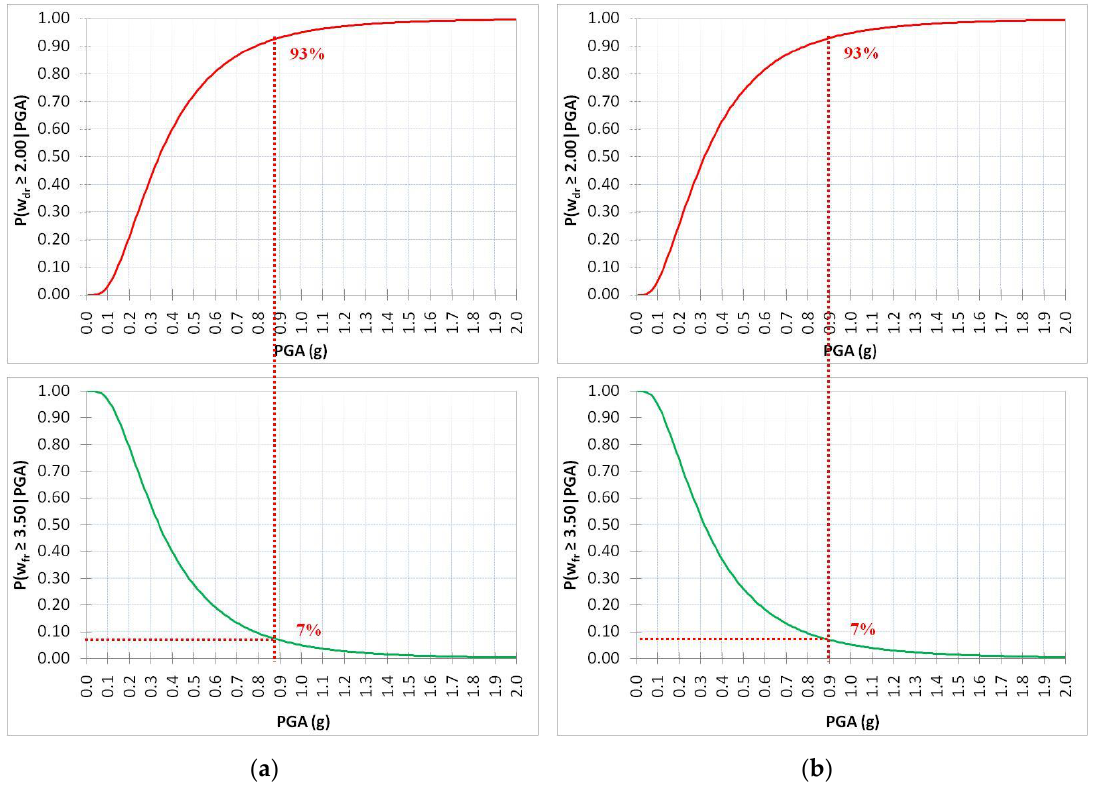
Figure 13. Comparison of the results with the real case (PGA = 0.87g) for ( a ) AC1 and ( b ) AC2.